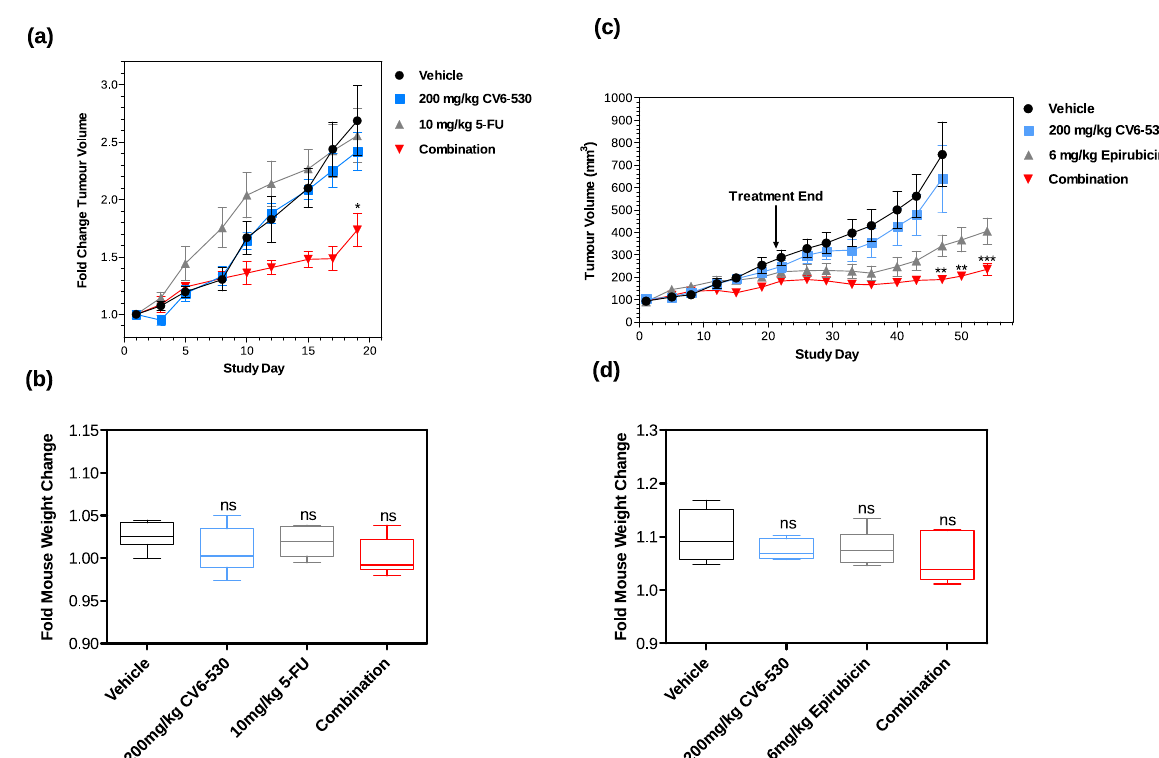
Fig. 7 CV6-530 enhances the ef fi cacy of SoC chemotherapies in TNBC in vivo xenograft model. a Line-graph representing the mean ± SEM tumour volume fold change of tumours implanted on mice treated with 200 mg/kg CV6-530 and/or 10 mg/kg 5-FU ( N = 5/group). b Box-plot comparing the mean ± SEM fold change in body weights (day 19 compared with day 1) of mice treated with 10 mg/kg 5-FU and 200 mg/kg CV6-530 alone or in combination ( N = 5/group). Centre line represents the median, bounds of the box represent upper and lower quartiles and whiskers represent the min and max values. c Line-graph representing the mean ± SEM tumour volume fold change of tumours implanted on mice treated with 200 mg/kg CV6-530 and/or 6 mg/kg epirubicin ( N = 6/group). d Box-plot comparing the mean ± SEM fold change in body weights of mice treated with 6 mg/kg epirubicin and 200 mg/kg CV6-530 alone or in combination ( N = 6/group). Centre line represents the median, bounds of the box represent upper and lower quartiles and whiskers represent the min and max values. One-way analysis of variance (ANOVA) for ( a ) and ( c ) and unpaired, two-tailed Student t -test for ( b ) and ( d ), * P < 0.05, ** P < 0.005, *** P <